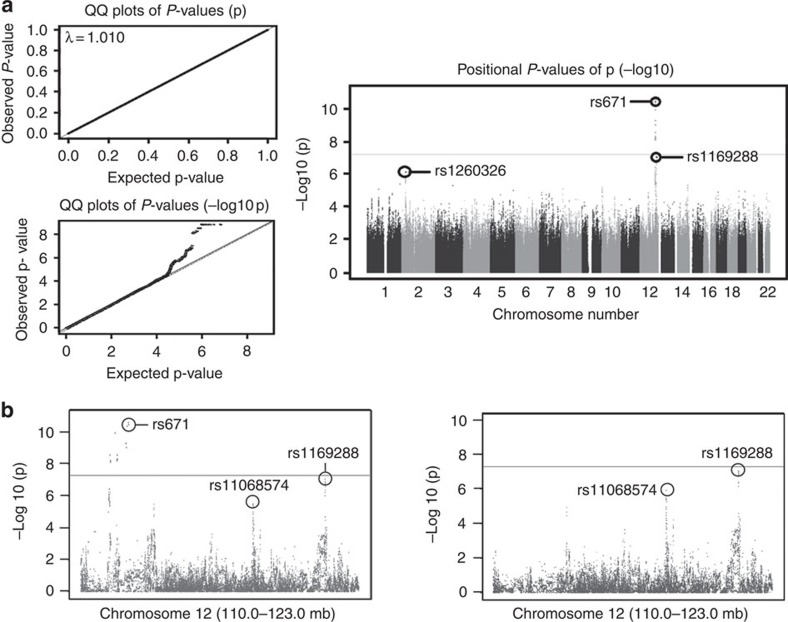
The results of GWAS on the serum AAT levels (n=3,294).(a) The quantile-quantile plots (left) and the Manhattan plot for the genome-wide scanning: The horizontal line indicates the genome-wide significant level, P=5.0 × 10−8. (b) The regional plot for a part of chromosome 12 for nominal (left) and conditional (right) associations adjusted for rs671 genotypes. P values were calculated by generalized linear regression model.